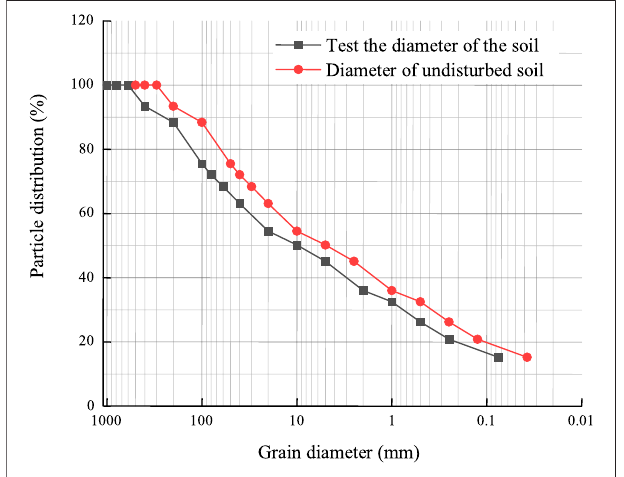
FIGURE 1 | Grading curve of whole stone slag diagram.